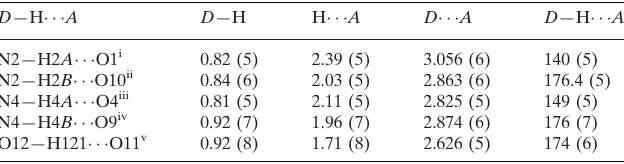
Data collection: APEX2 (Bruker, 2007); cell refinement: